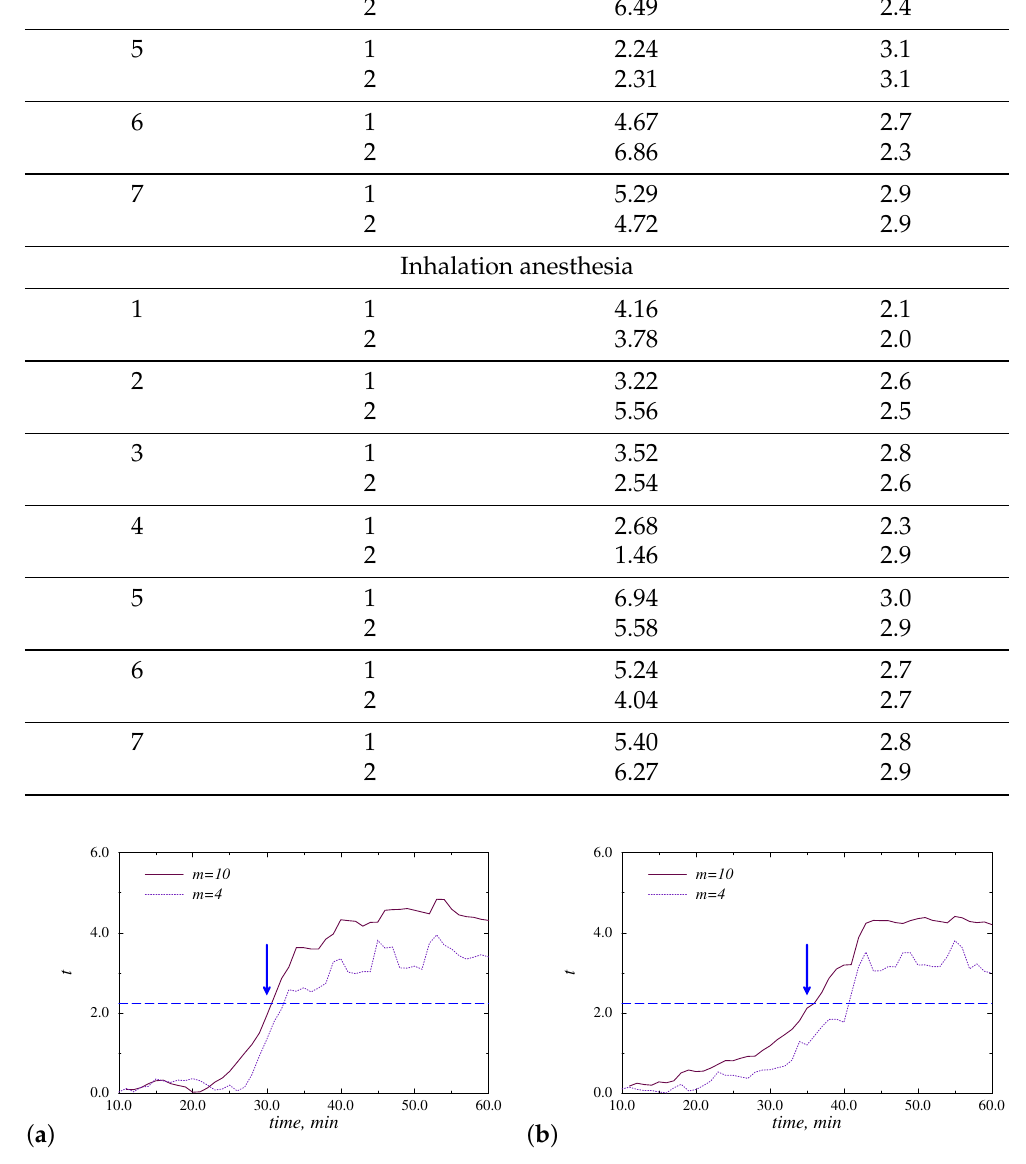
Figure 5. Examples of the t -values estimated by comparing m beginning 1-min EEG-segments with subsequent segments in a sliding window approach. The time of administration of anesthesia is marked with an arrow. Results are shown for injection ( a ) and inhalation ( b ) anesthesia. The dashed line indicates the critical value t c = 2.228 associated with p <